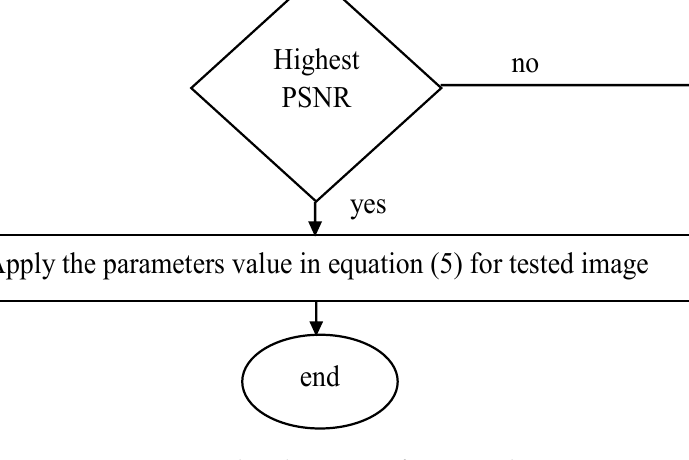
Figure 3. Flowchart steps of image scaling.